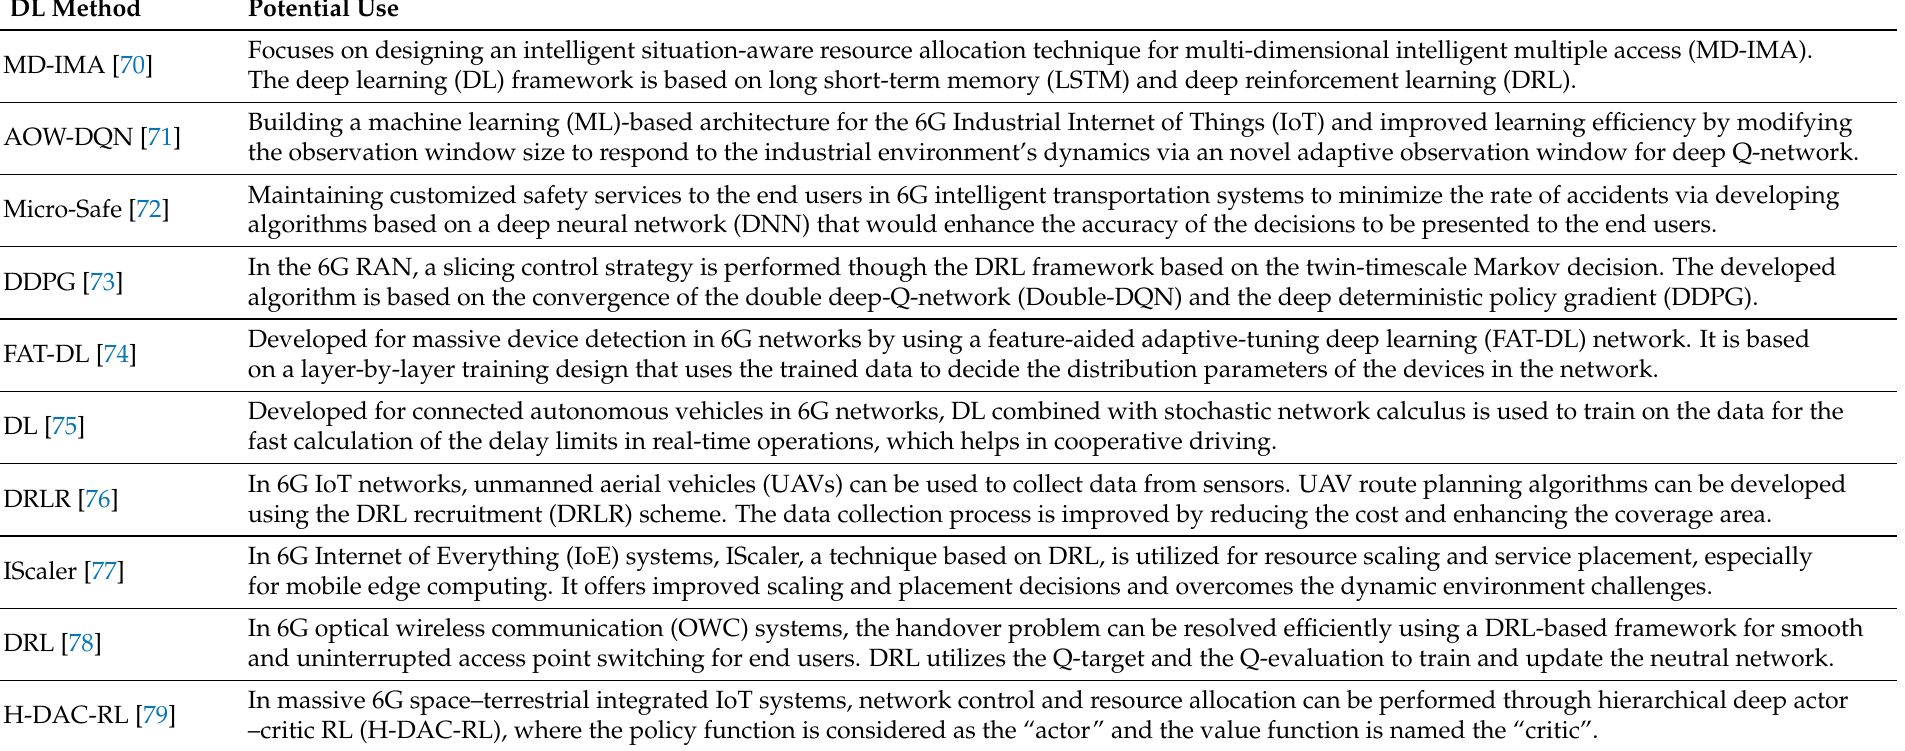
Table 1. An overview of promising deep learning methods in 6G